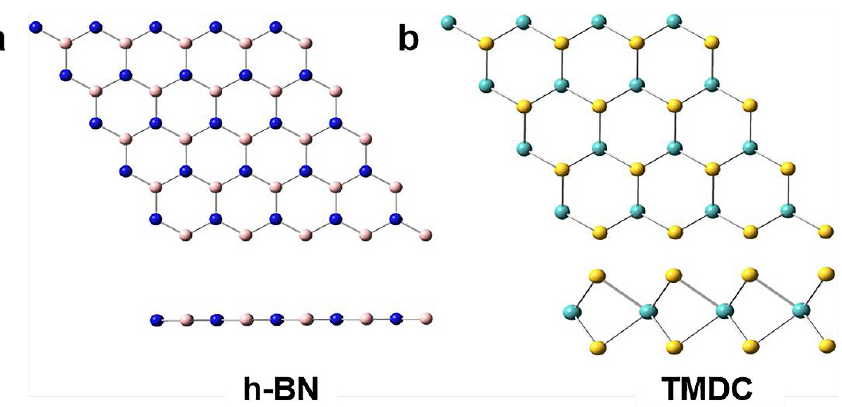
Figure 3. ( a ) Structure of h-BN layers and ( b ) TDMC [31]. Copyright © 2021 Elsevier B.V., Computational and Theoretical Chemistry.